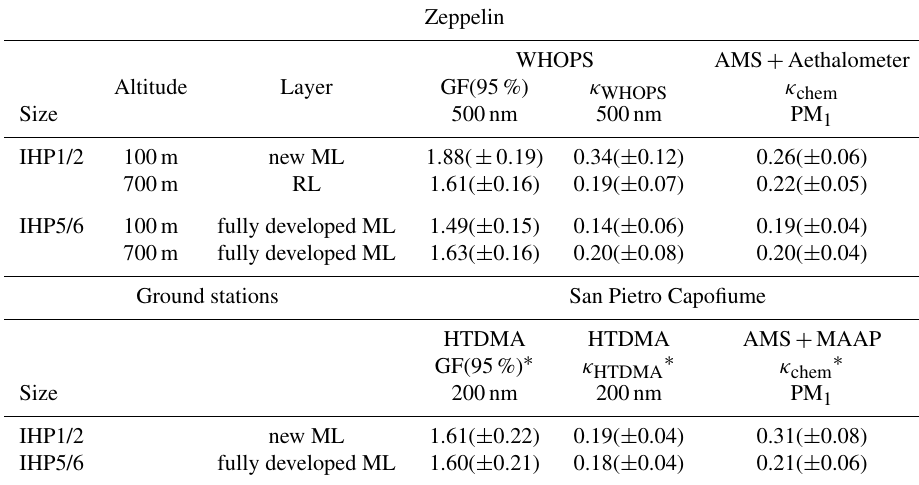
Table 2. Mean GF(95%) and κ values for IHP1/2 and IHP5/6 with respective accuracies. κ chem is the calculated κ using the AMS and aethalometer measurements on board of the Zeppelin NT or AMS/MAAP combination at the SPC ground station. Besides, results for two different altitudes and the corresponding layers probed are mentioned. Additionally, the size at which the measurements are performed is